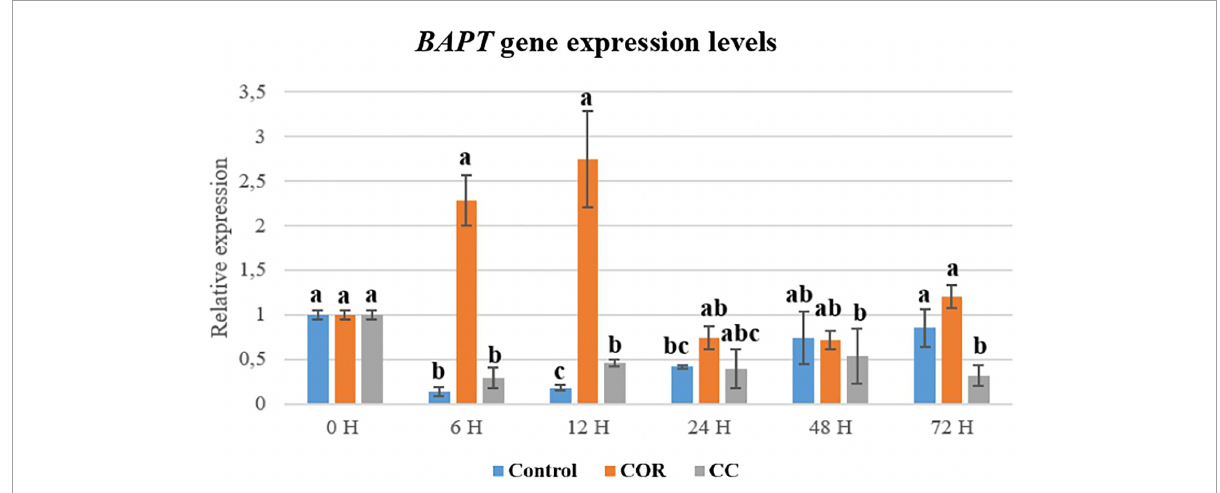
FIGURE11 Relative expression of the BAPT gene in T. baccata cell cultures grown in Control conditions and elicited with 1 mM coronatine (COR) or 1 mM coronatine + 50 mM methyl- β -cyclodextrins (CC). Values presented are means ± SD ( n = 3). Values followed by different letters are significantly different (P ≤ 0.05) according to Tukey’s honestly significant difference